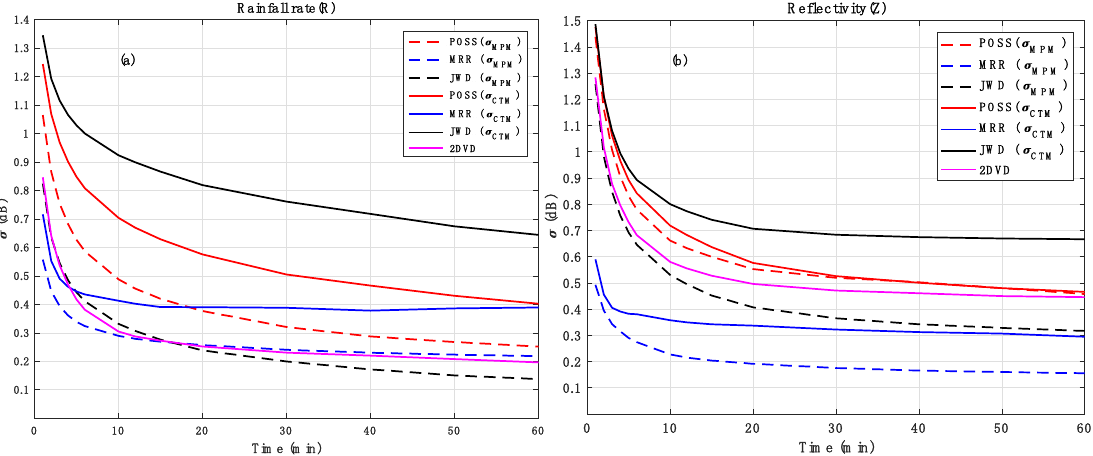
Figure 12. The mean values of σ in ( a ) rainfall rate (R) and ( b ) radar reflectivity (Z) for the four types of